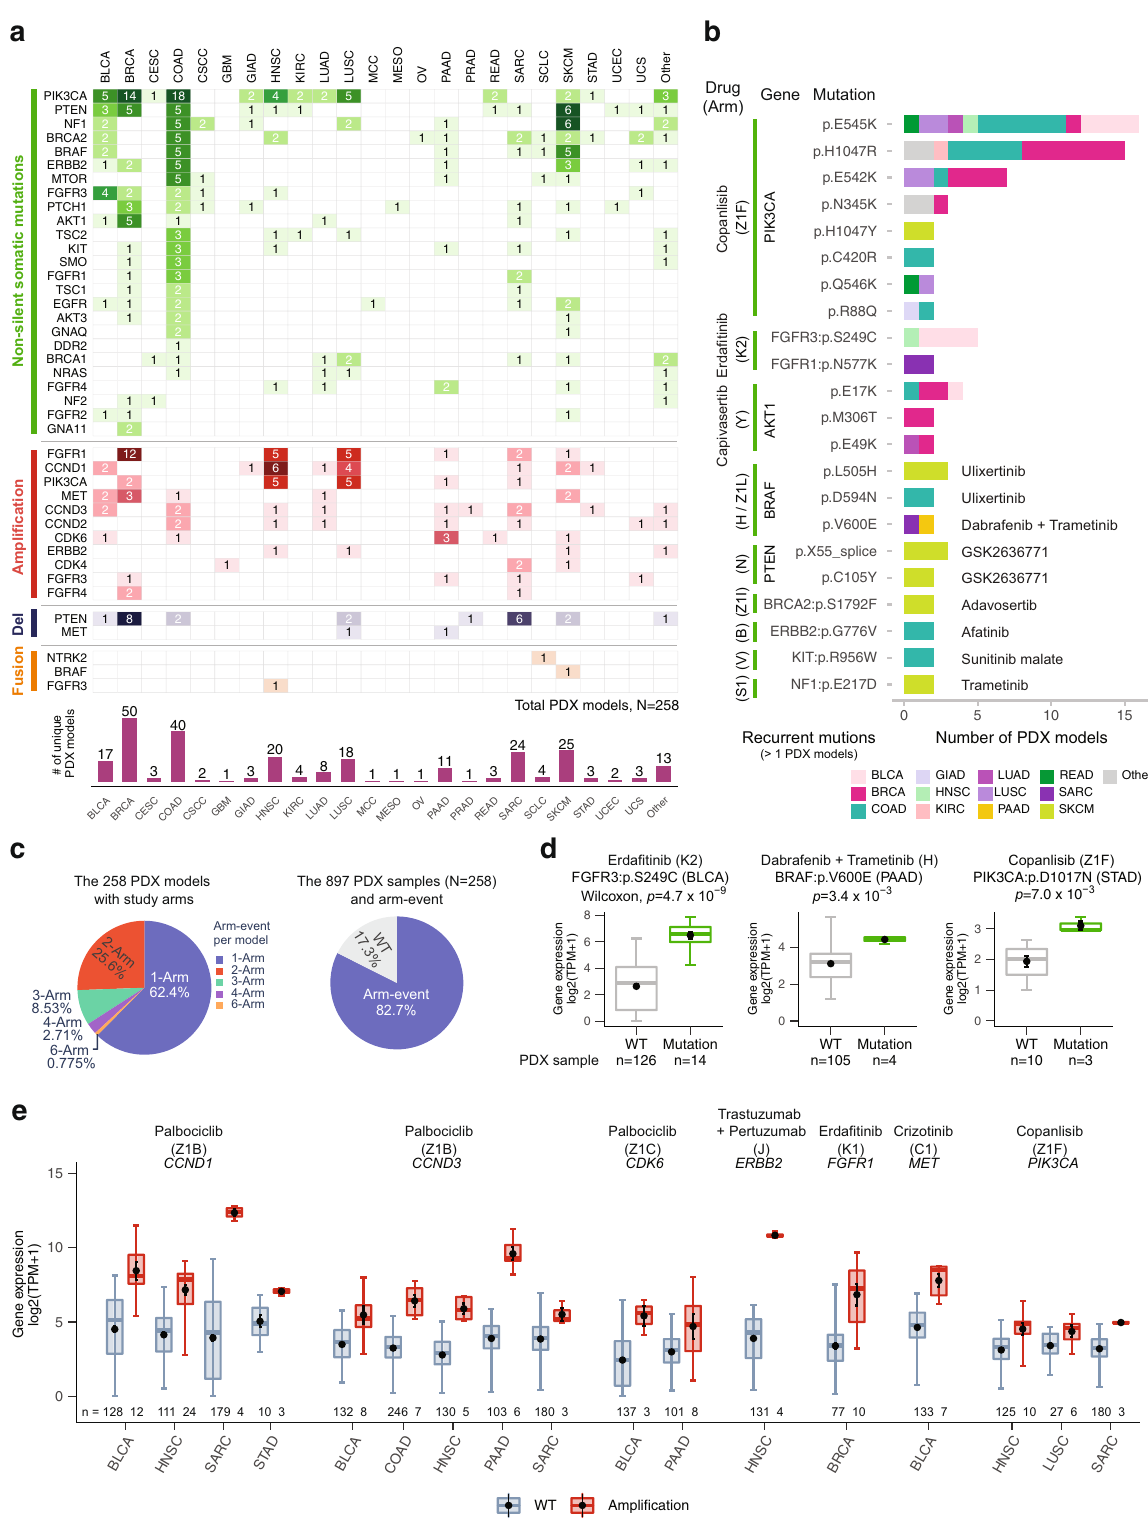
Sample quality estimate . To check for consistency across sample lineages, we developed a sequence data quality control algorithm named SeqQEst (Beta version, github.com/ding-lab/SeqQEst) to detect potentially mislabeled, swapped, and tissue-contaminated samples that occasionally appear, especially in large cohorts of sequencing data. SeqQEst has two main pipelines: (1) Sequence QC (SeqQC): to estimate bam fi le status (total reads, mapping percentage, average read length, mean mapping quality, insert size, and coding region coverage) and to provide a FastQC summary report; (2) Sample germline QC (GermlineQC): to detect sample